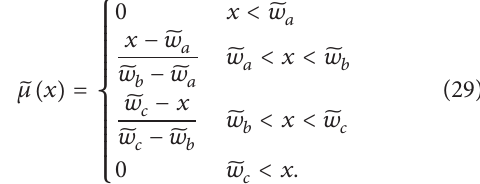
Table 6: The optimal levels of the algorithms’ parameters for problem 7 of Table